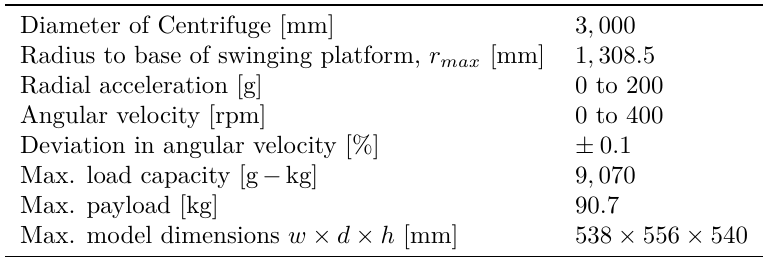
Table 1. Technical specifications of the centrifuge at BOKU 6